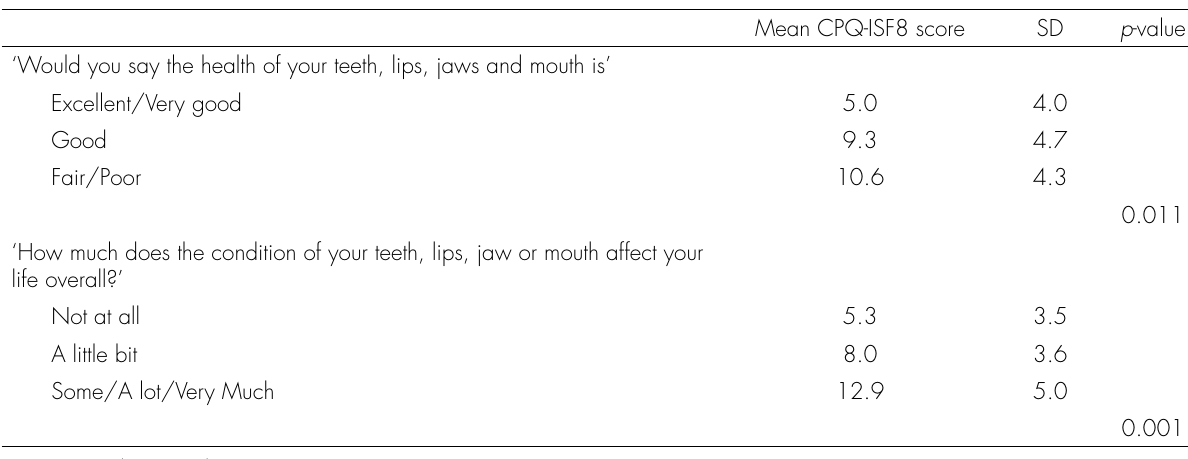
Table II. Mean CPQ-ISF 8 score by global oral health